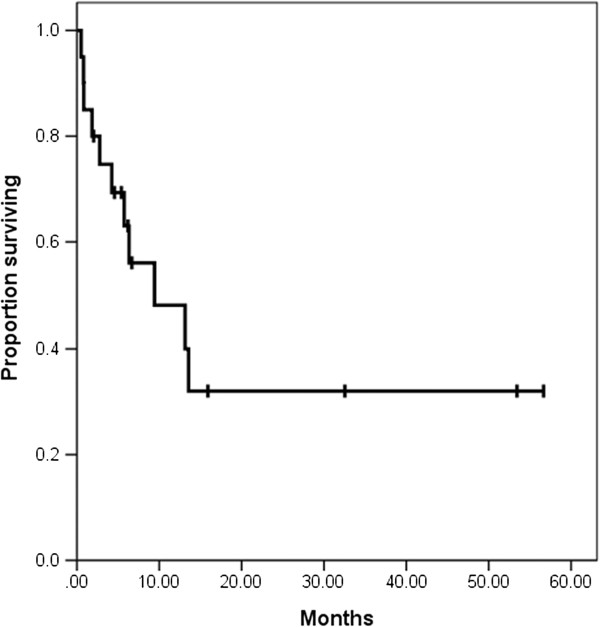
Kaplan-Meier overall survival curve for patients who received RT (radiotherapy) for MS (post RT survival rate).